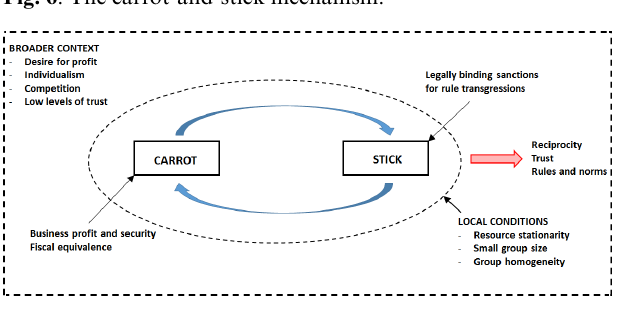
Fig. 6 . The carrot-and-stick